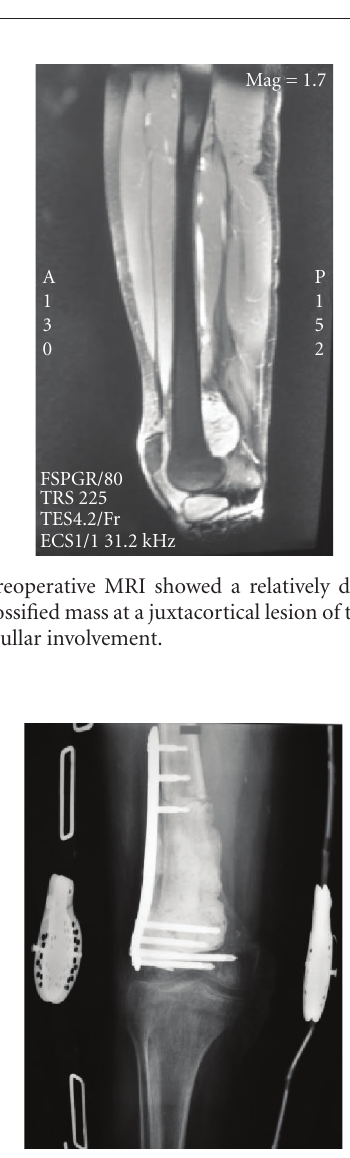
Figure 4: Cement, plate (LISS-SYNTHES), and screws were used for the reconstruction of the distal femoral